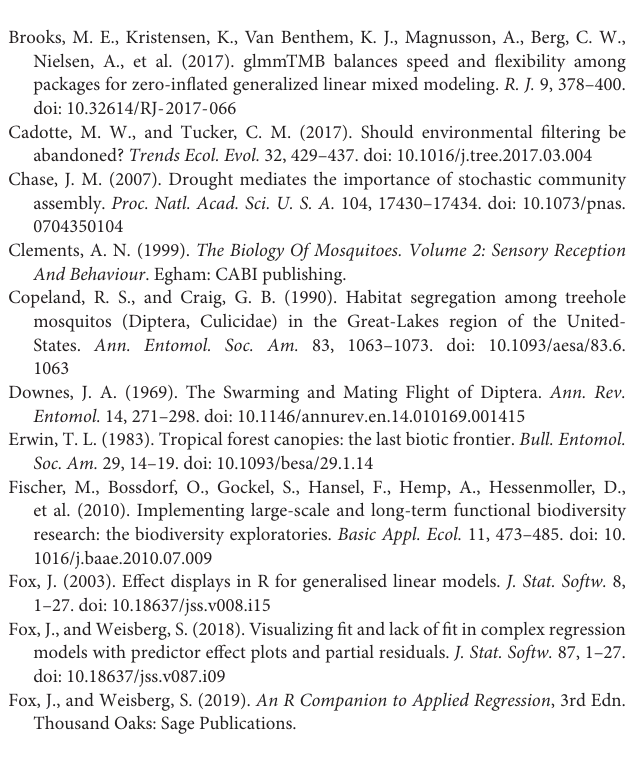
Supplementary Figure 1 | Standardized model coefficients (including conditional and marginal R 2 -values) of generalized linear mixed effects models with a Poisson distribution, showing the importance of tree-hole height above ground, plot-level tree-hole density (separated by canopy and ground), tree-hole opening area, tree-hole maximum water volume (Vmax), water chemistry (dissolved oxygen concentration (O 2 ), pH, and ammonium, nitrate and phosphate concentrations), and total amount of detritus relative to Vmax (PropDetritustot) in determining the abundance of the five most frequently observed insect species. (A) Diptera, Culicidae: Aedes geniculatus , occurrence in n = 88 tree holes; (B) Diptera, Ceratopogonidae: Dasyhelea sp., n = 109; (C) Diptera, Chironomidae: Metriocnemus cavicola , n = 194; (D) Diptera, Syrphidae: Myiatropa florea , n = 139; (E) Coleoptera, Scirtidae: Prionocyphon serricornis , n = 131. (F,G) show the total abundance and the frequencies of occurrence of the five species, respectively. * p < 0.05, ** p < 0.01, *** p < 0.001. Supplementary Figure 2 | Prediction of the abundance of the most abundant species in our study as a function of tree-hole height above ground, based on generalized linear mixed effects models with a Poisson distribution, including tree-hole-scale and plot-scale variables (tree-hole density was assessed separately for canopy and ground holes) as additional predictors. The gray bands show 95% confidence intervals. The bars on the x-axis indicate the tree holes sampled along the vertical gradient. (A) Diptera, Culicidae: Aedes geniculatus occurrence in n = 88 tree holes; (B) Diptera, Ceratopogonidae: Dasyhelea sp., n = 109; (C) Diptera, Chironomidae: Metriocnemus cavicola , n = 194; (D) Diptera, Syrphidae: Myiatropa florea , n = 139; (E) Coleoptera, Scirtidae: Prionocyphon serricornis , n =